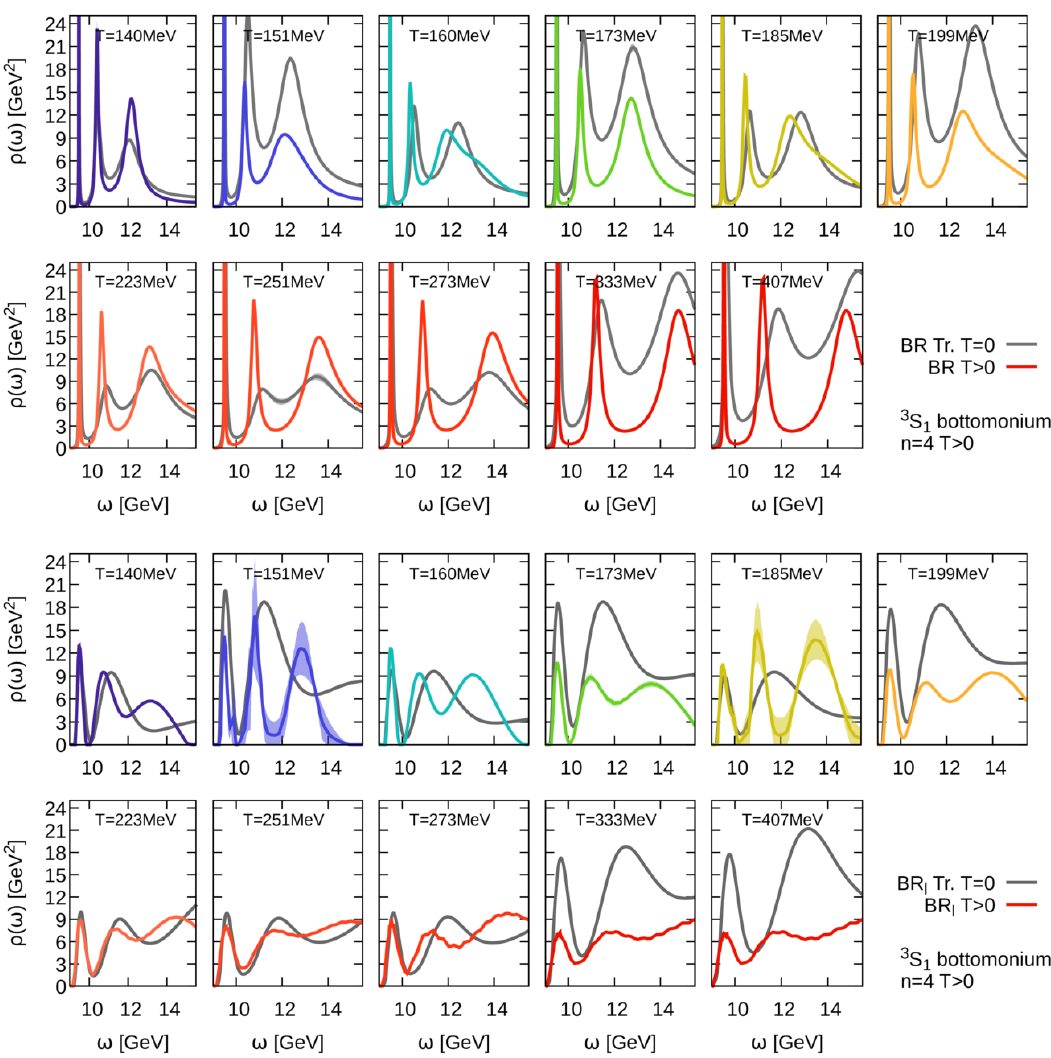
Figure 40 . Comparison of the (top) BR truncated at T = 0 and at T > 0 (bottom) the same comparison for the smooth BR method in the 3 S 1 bottomonium channel. Note the di(cid:11)erence in statistics available between T = 0 and T > 0 here. For Charmonium the statistics in the two cases are the